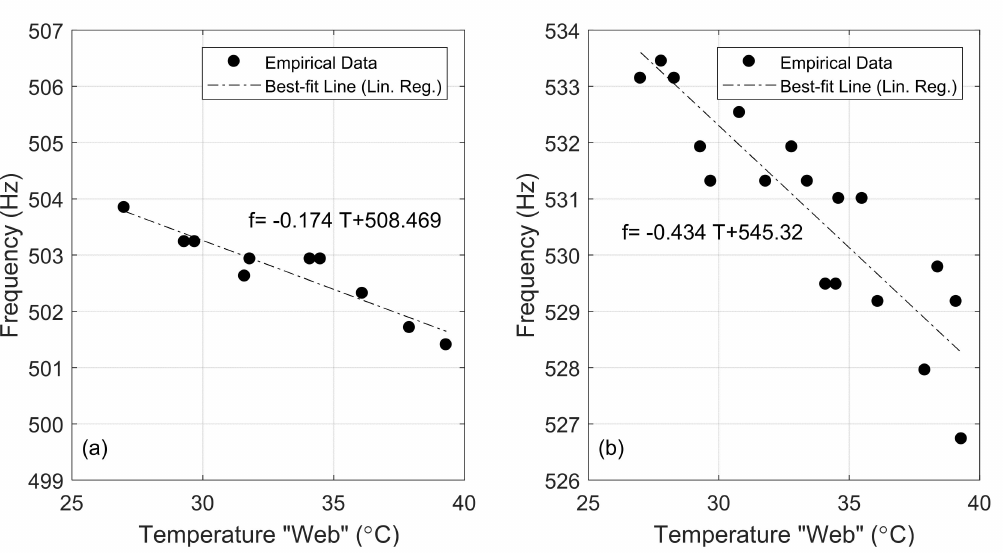
Figure 11. ( a ) Frequency peaks associated with ( a )-peak around 500 Hz and ( b )-peak around 530 Hz as a function of the web temperature recorded at the moment of the lateral